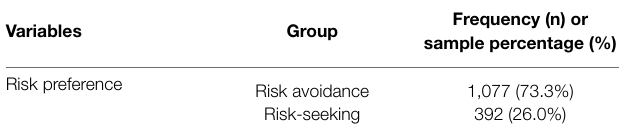
TABLE 8 | Risk preference grouping ( n = 1,469).